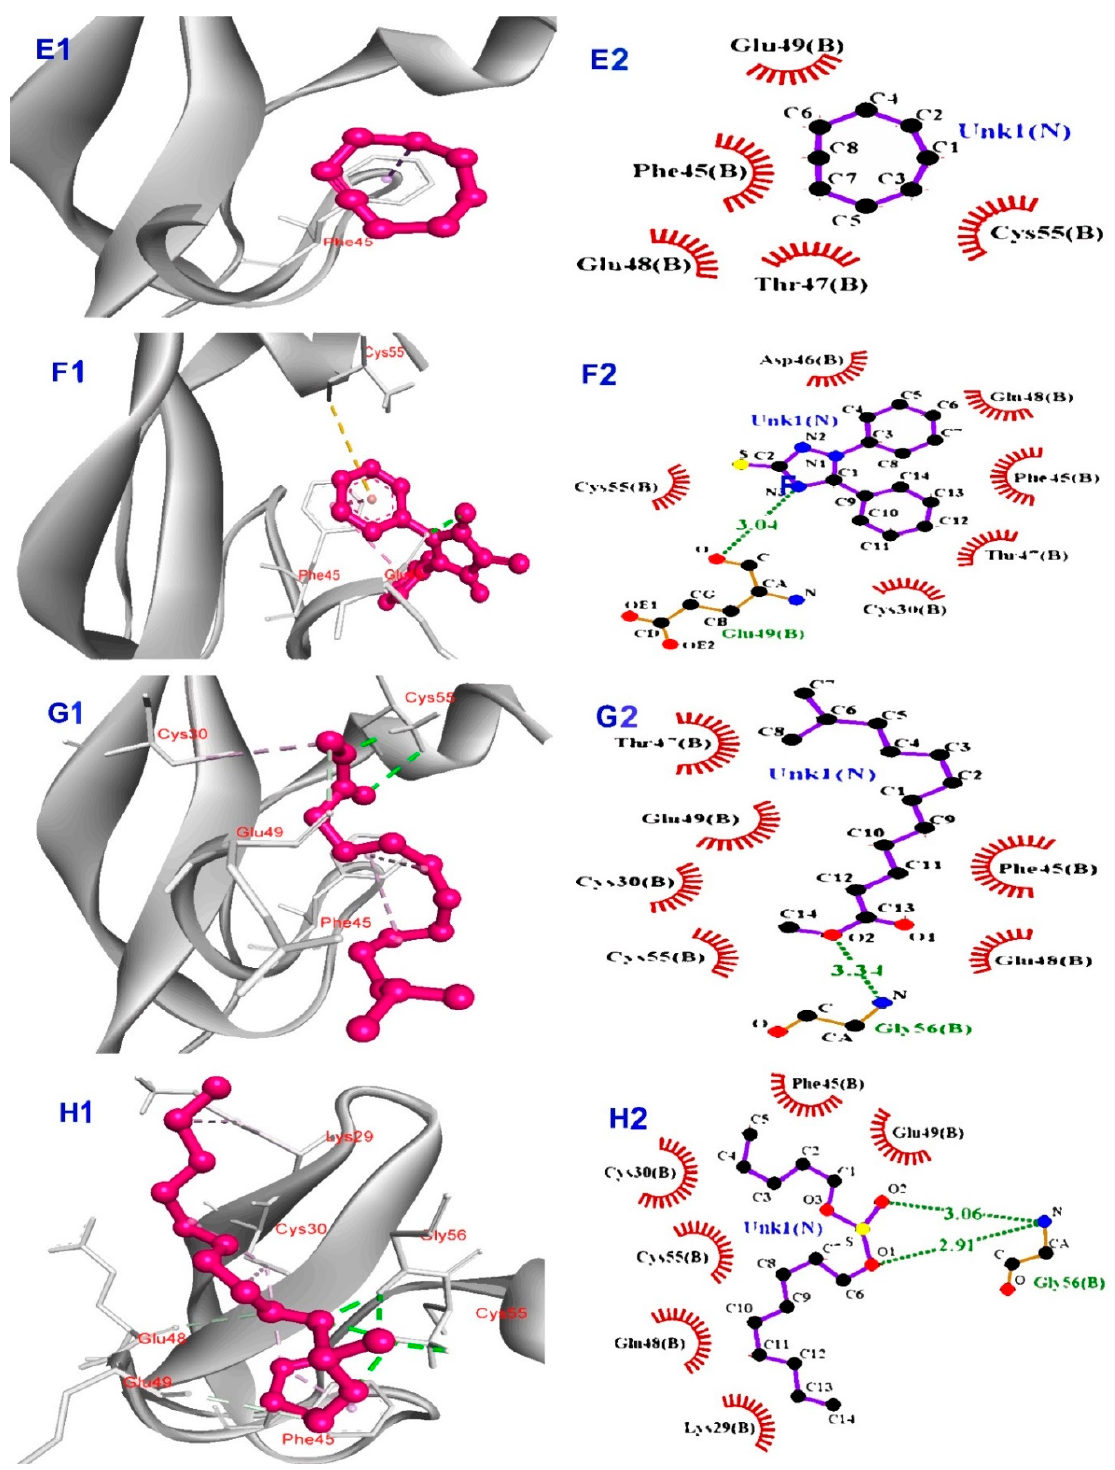
Figure 4. Binding of phytochemicals with the targeted protein (1AAP). Here, the left side indicates a 3D structure, and the right side indicates a 2D structure of ligand-beta-amyloid precursor protein-binding complexes. In the 3D structure, ligand molecules were represented in pink color with a ball and stick model and binding amino acids by letters and a number format which are red in color. In the 2D structure, hydrogen bonding interactions are shown by the olive dotted green line and hydrophobic interactions with the nearest amino acid residues in the red spike. ( A ) Control drug Rivastigmine; ( B ) O-Xylene; ( C ) 1-Hexanone, 1-phenyl; ( D ) 3-n-Hexylthiolane, s,s-dioxide; ( E ) Sulfurous acid, nonyl pentyl ester; ( F ) 1,5-Diphenyl-2h-1,2,4-triazoline-3-thione; ( G ) Methyl 11-methyl-dodecanoate; ( H ) 1,2-Cyclooctadiene.